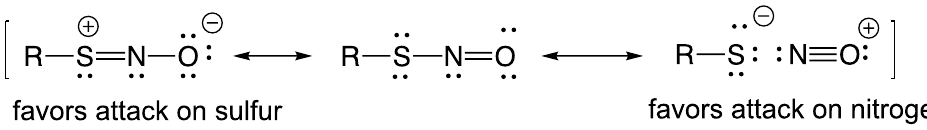
Figure 3. RS-NO resonance forms that favor attack at either sulfur or nitrogen.